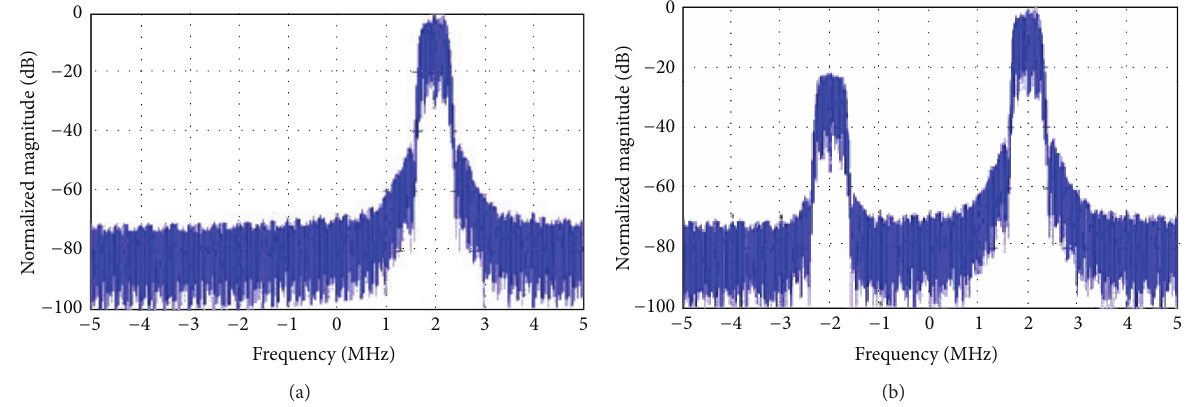
Figure 11: Comparison of frequency before (a) and after (b) the insertion of